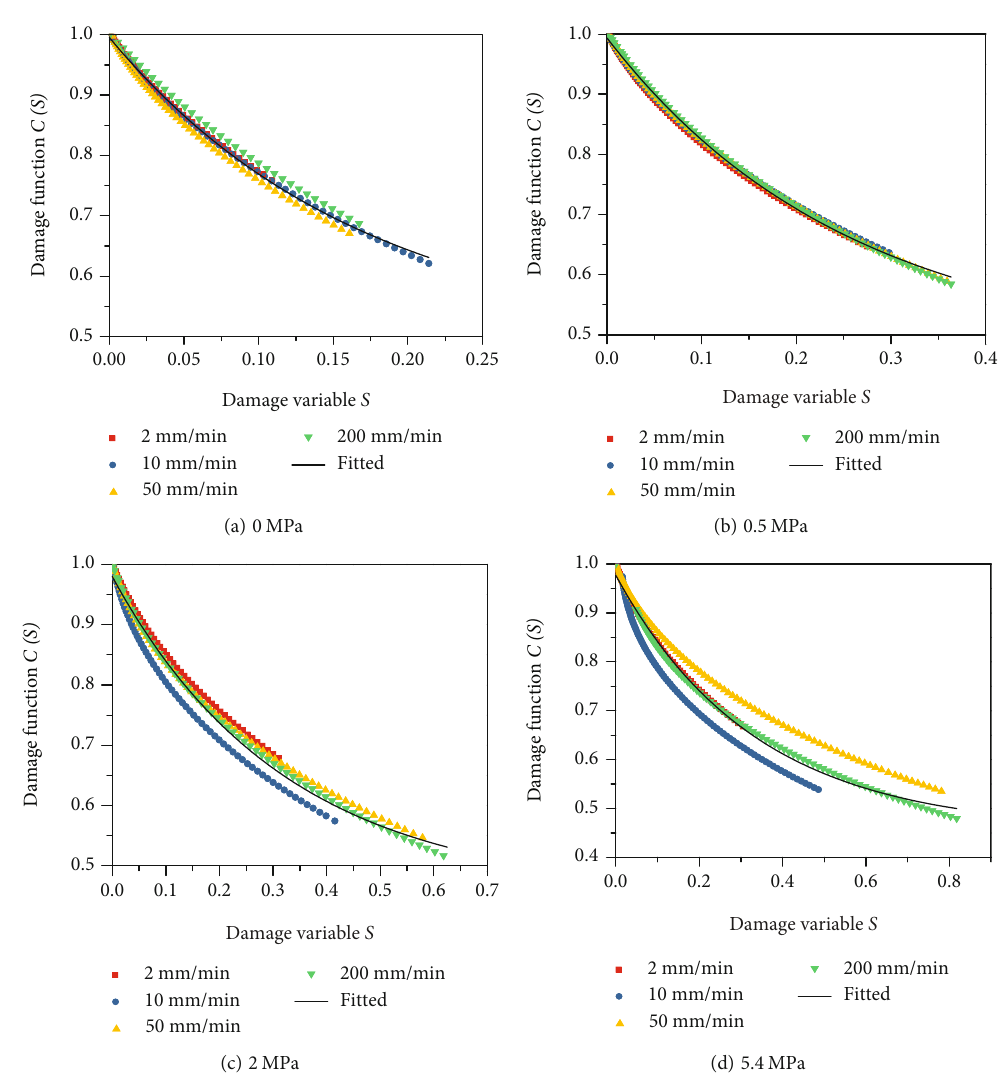
Figure 8: N15 pro fi le of propellant.